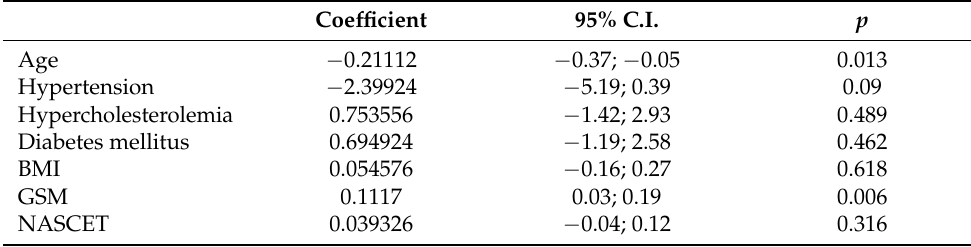
Table 5. Linear regression analysis for prediction of z-score at